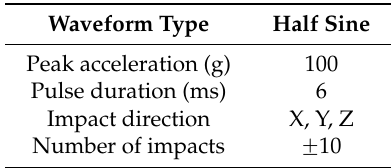
Table 7. Impact test conditions. Table 8. Dust test